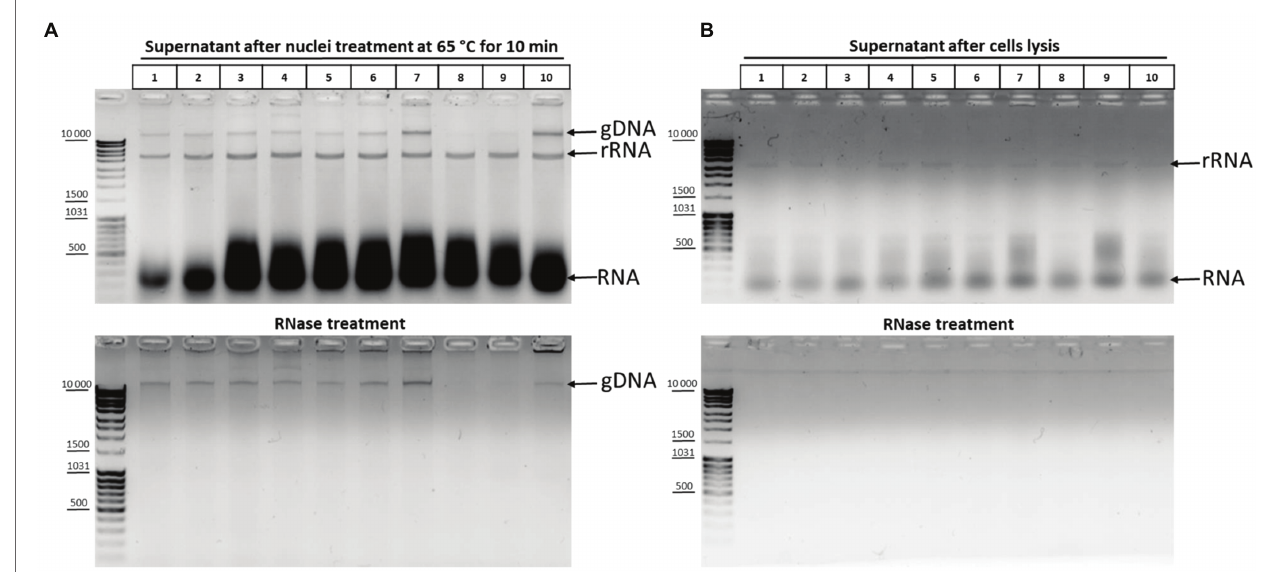
FIGURE 3 | DNA and RNA release from nuclei upon their treatment with heat in the presence of SDS. (A) Chromatin treatment at 65 ° C causes DNA release from nuclei. С ells were fixed, quenched, and washed after quenching with 1X PBS as in Figures 2A – C and then lysed in hypotonic lysis buffer #11 (see Table 1 ), incubated on ice for 15 min, washed once with ice-cold 1X PBS, and resuspended in 1X RB for DpnII. Then, SDS was added up to 0.3% and the nuclei were treated with heat at 65 ° C for 10 min + 37 ° C for 50 min. After that, Triton X-100 was added up to 1.8% and the nuclei were incubated at 37 ° C for 1 h. Thereafter, the samples were separated into the supernatant (100 μ l) and the pellet and 500 μ l of EB was added to the supernatant fractions (lanes 1–10, 10 replicates of the experiment). Then, the cross-links were reversed and the DNA was extracted, precipitated, dissolved, and treated with bovine RNase A (lower panel) as in Figures 2A – C or left untreated (upper panel). The amount of the DNA subjected to electrophoresis was 2 μ l. gDNA – genomic DNA, rRNA – processed high- molecular-weight RNA, and RNA – low-molecular-weight RNA (tRNA + degraded mRNA). (B) The content of nucleic acids in the supernatant after the stage of cell lysis. С ells were lysed on ice as in A and the samples were separated into the supernatant containing cytoplasm (100 μ l) and the pellet fractions. EB was added to the supernatant fractions as in A . Then, the cross-links were reversed and the DNA was extracted, precipitated, dissolved, and treated with bovine RNase A (lower panel) or left untreated (upper panel) and subjected to electrophoresis as in Figures 2A – C . All other designations are as in A